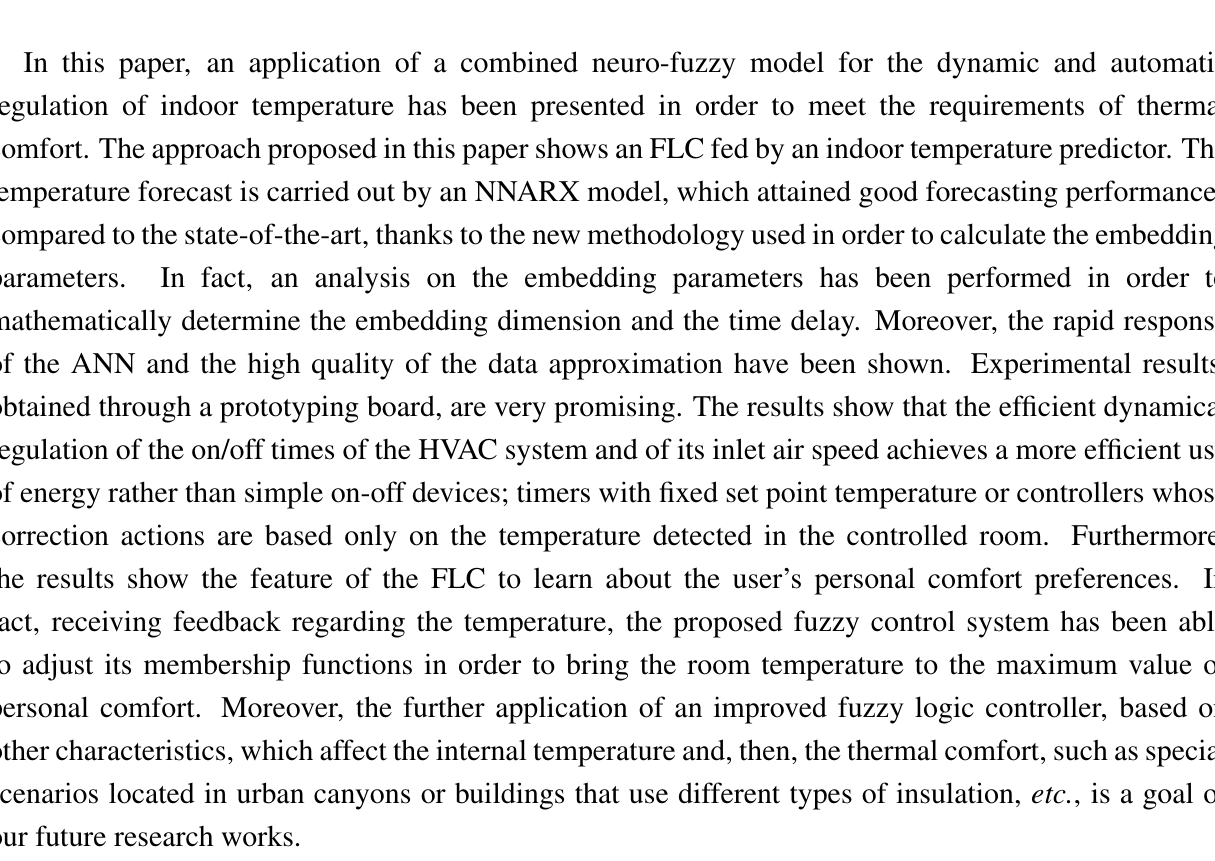
Figure 11. Adjusted membership functions for T